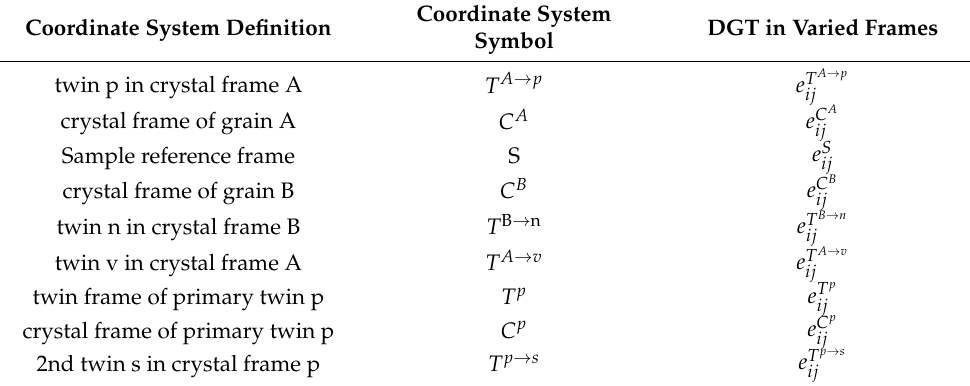
Figure 1. ( a ) Illustration of twin interactions between grain A and B. Primary twin marked as p in grain A adjacent to the primary twin marked as n in grain B. Another twin variant labeled as v interacts with p within which secondary twin s appears; ( b ) coordinate systems expressed in the crystal of grain A; ( c ) coordinate systems expressed in primary twin p. Table 1. Coordinate systems and corresponding DGT.